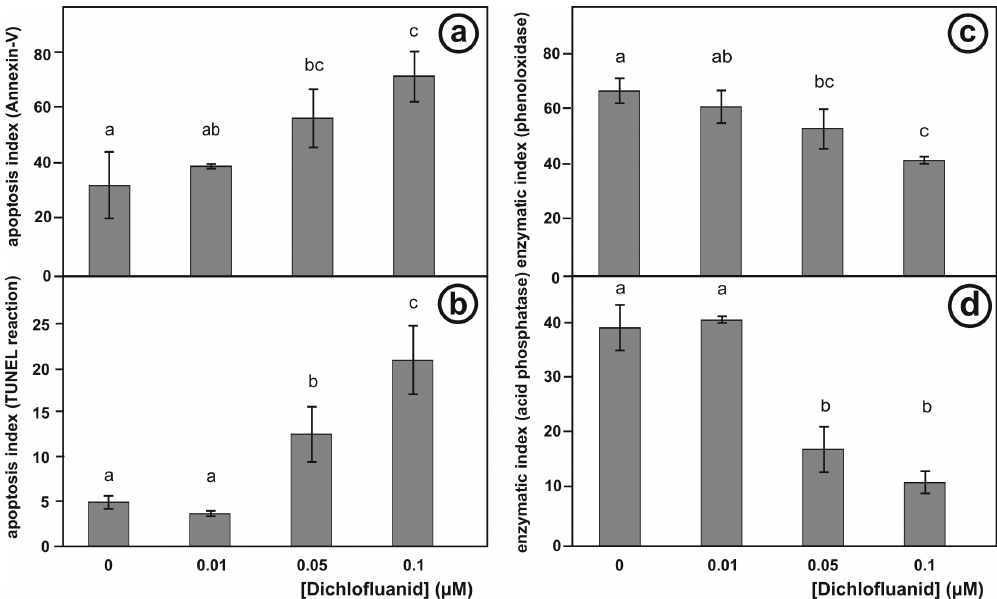
Figure 4. Indexes of early ( a ) and late ( b ) apoptosis evaluated with the annexin-V assay and TUNEL reaction, respectively, and enzymatic indexes of phenoloxidase ( c ) and acid phosphatase ( d ) activities of the cytotoxic and phagocytic lines, respectively, in the presence of various concentrations of dichlofluanid. Control (0) refers to the absence of dichlofluanid. The results are expressed as the mean percentage of cells with positive staining ± SD (n = 3) compared to the total number of cells. Significant (p < 0.05) differences are expressed with different letters.